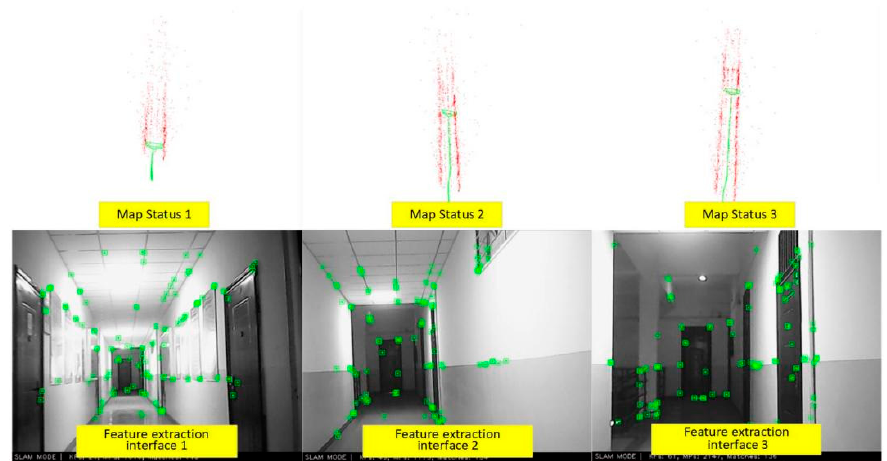
Figure 7. Three-dimensional sparse-point cloud map construction process. points of the corridor and corridor, the green part of the map state interface is the track of